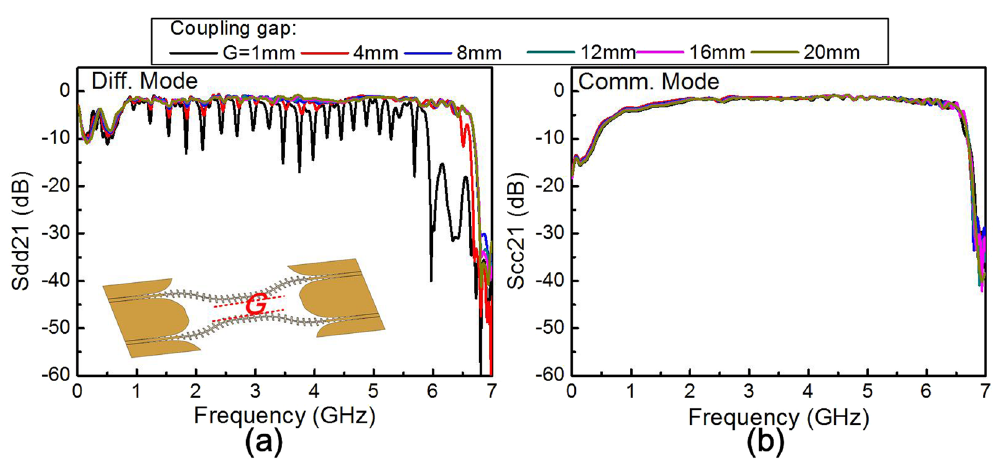
Figure 3. The effect of the coupling gap on transmission coefficient of (a) differential mode ( S dd 21) and (b) common mode ( S cc